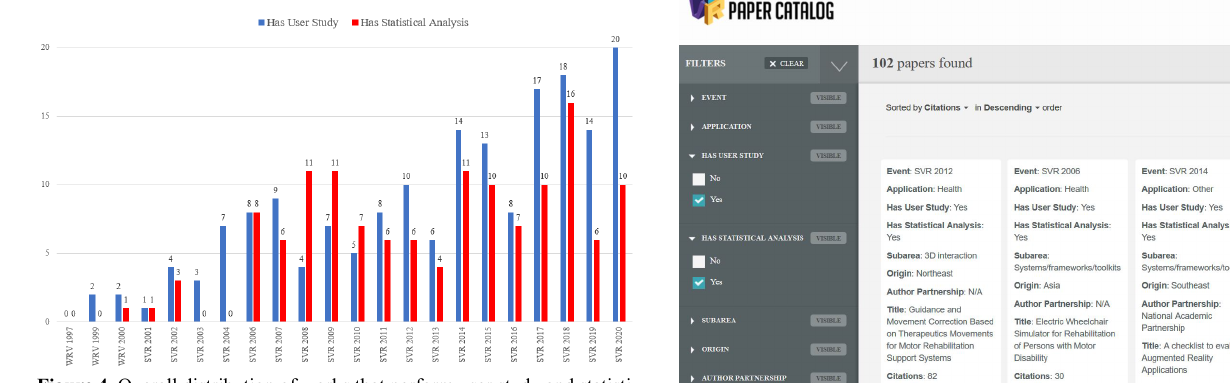
Figure 4. Overall distribution of works that perform user study and statisti- cal analysis.